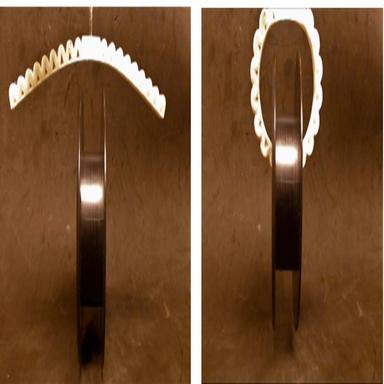
Grip functionality under a pressure of 24 psi.